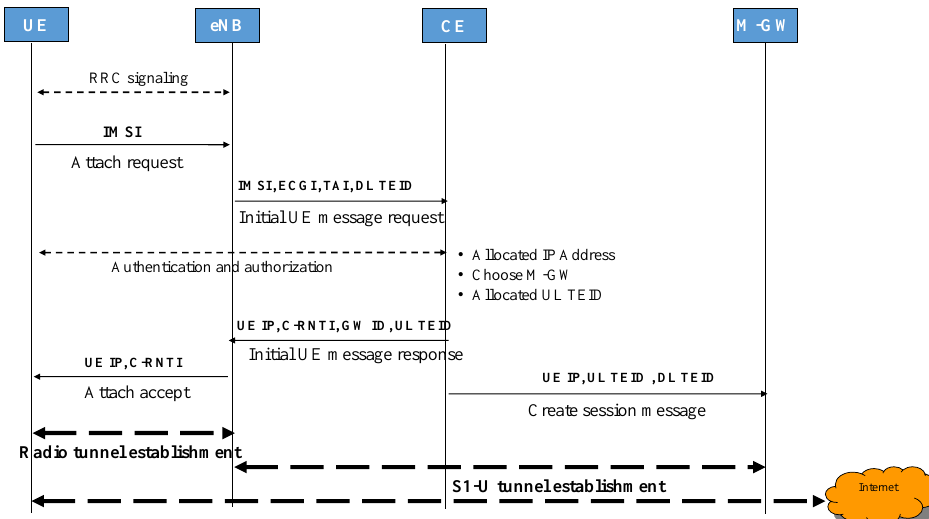
Figure 3. The initial attach procedure in the proposed 5G